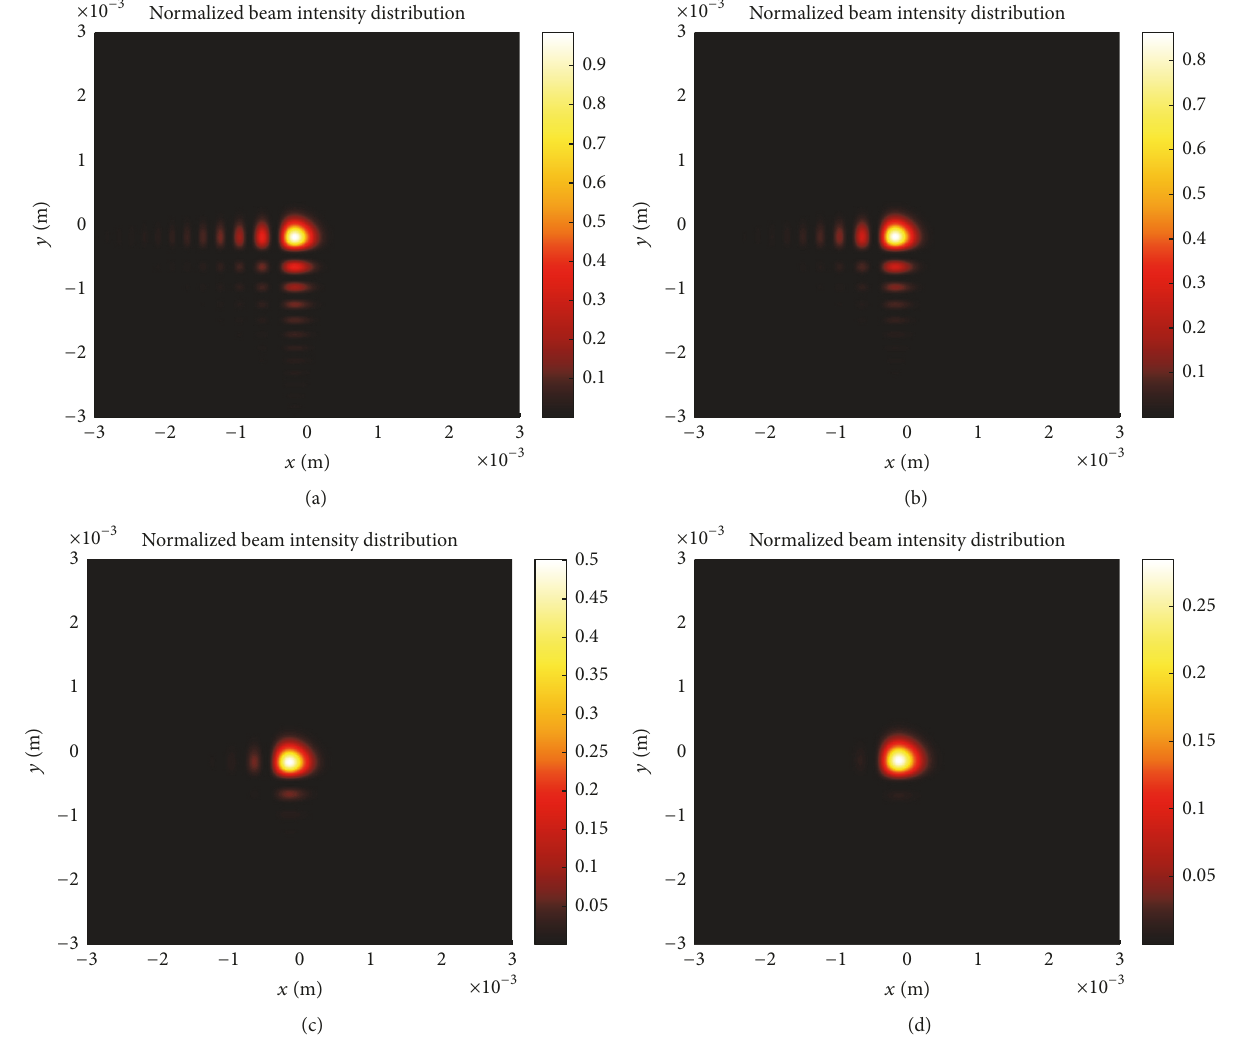
Figure 4: Emerging beam intensity profiles with four different collision frequencies 𝛾 𝑒 . (a) 𝛾 𝑒 = 0.2 THz, (b) 𝛾 𝑒 = 2.0 THz, (c) 𝛾 𝑒 = 10 THz, and (d) 𝛾 𝑒 = 20 THz.